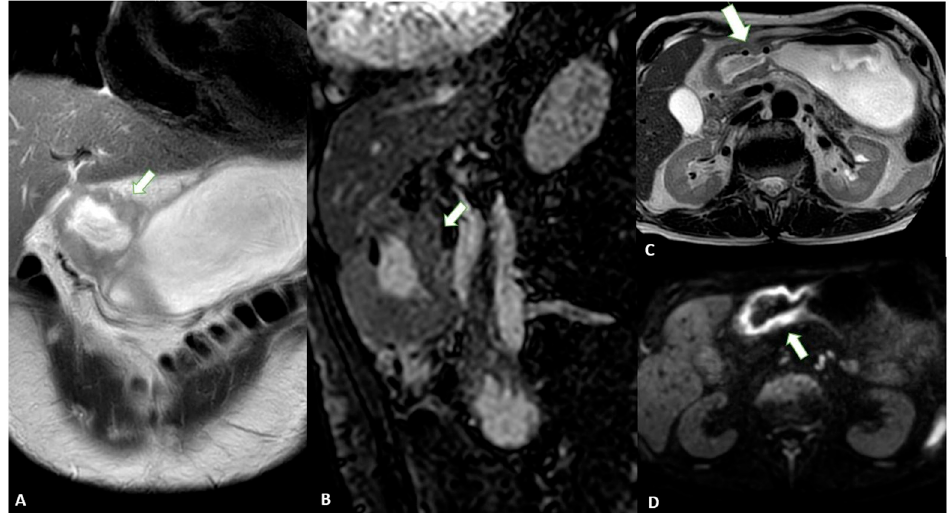
Figure 9. MRI images of a T3 gastric cancer of the gastric antrum in a 79-year-old male patient. ( A ) Coronal 2D image and ( C ) Axial 2D image of the Turbo Spin Echo (TSE) T2 sequence showing a circumferential lesion (arrow) invading the subserosa layer with an intermediate signal intensity; ( B ) Coronal 2D Balance Fast Field Echo (BFFE) sequence showing a circumferential lesion (arrow) with a low signal intensity; ( D ) Axial Diffusion Weighted Image (DWI) showing an area of signal restriction (arrow) corresponding to the tumor.